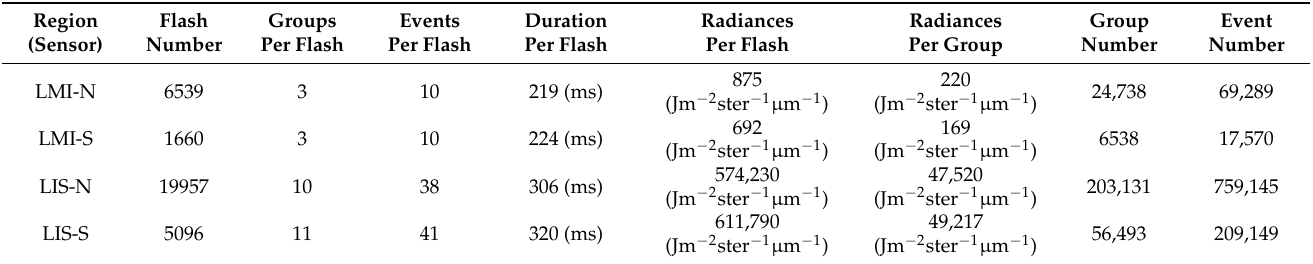
Figure 1. The expected FOV coverage (the black solid line) of LMI together with the annual Event density (in units of number of flashes grid − 1 year − 1 ) distribution based on the FY-4A LMI dataset and ISS-LIS dataset during 2018–2020. ( a ) FY-4A LMI and ( b ) ISS-LIS. The LMI data have been selected by using similar time frames limited by the temporal coverage of the ISS data in order to assess the differences in the performance of both sensors. The FOV of LMI in Australia is from January to March and October to December during 2018–2020 (LMI-South, LMI-S). The FOV of LMI in China is from April to September during 2018–2020 (LMI-North, LMI-N). Table 1. Mean LMI lightning properties during